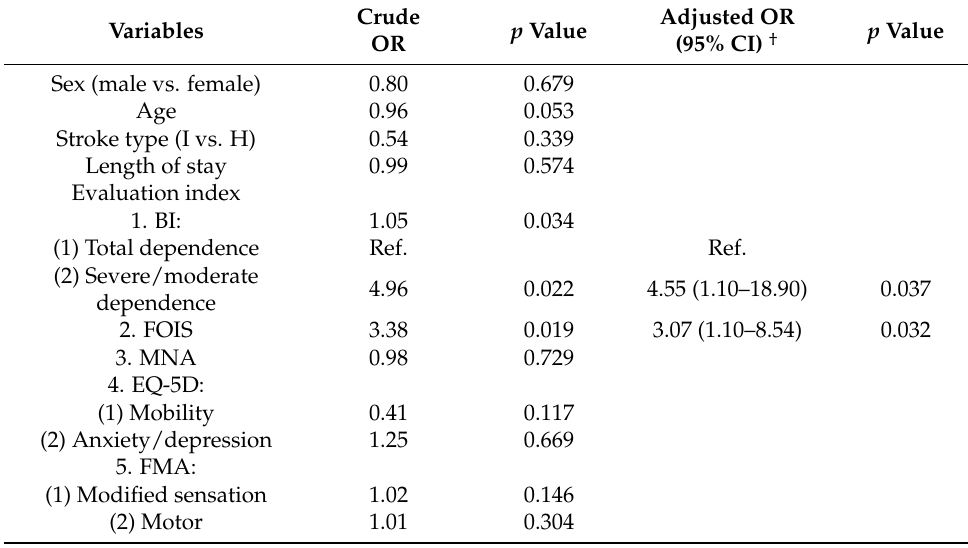
Table 3. Predictive factors for nasogastric tube